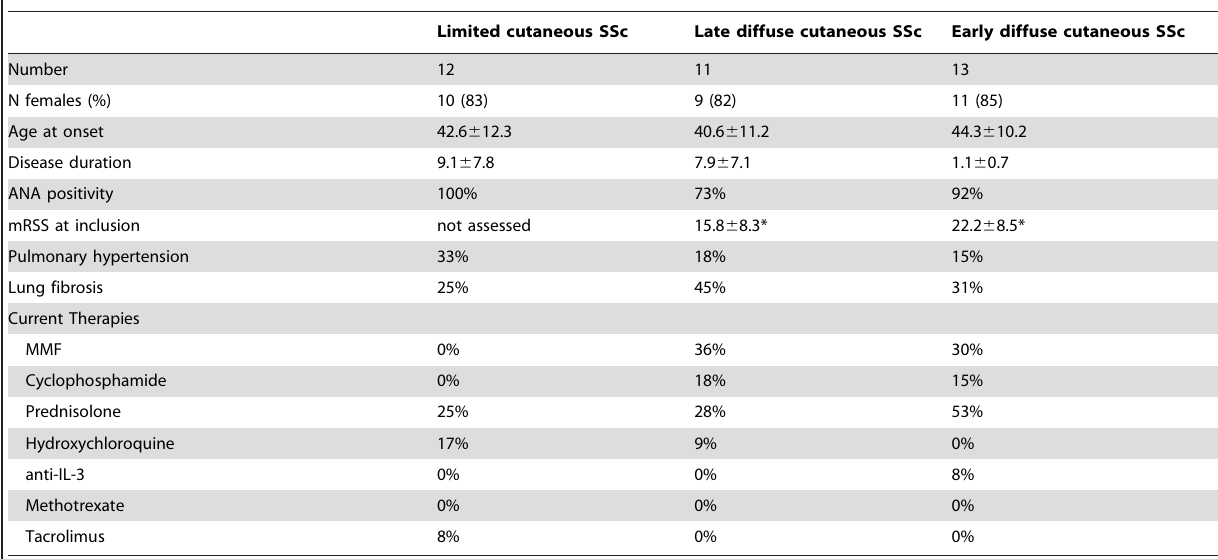
Table 1. Clinical characteristics of patients included in in vitro